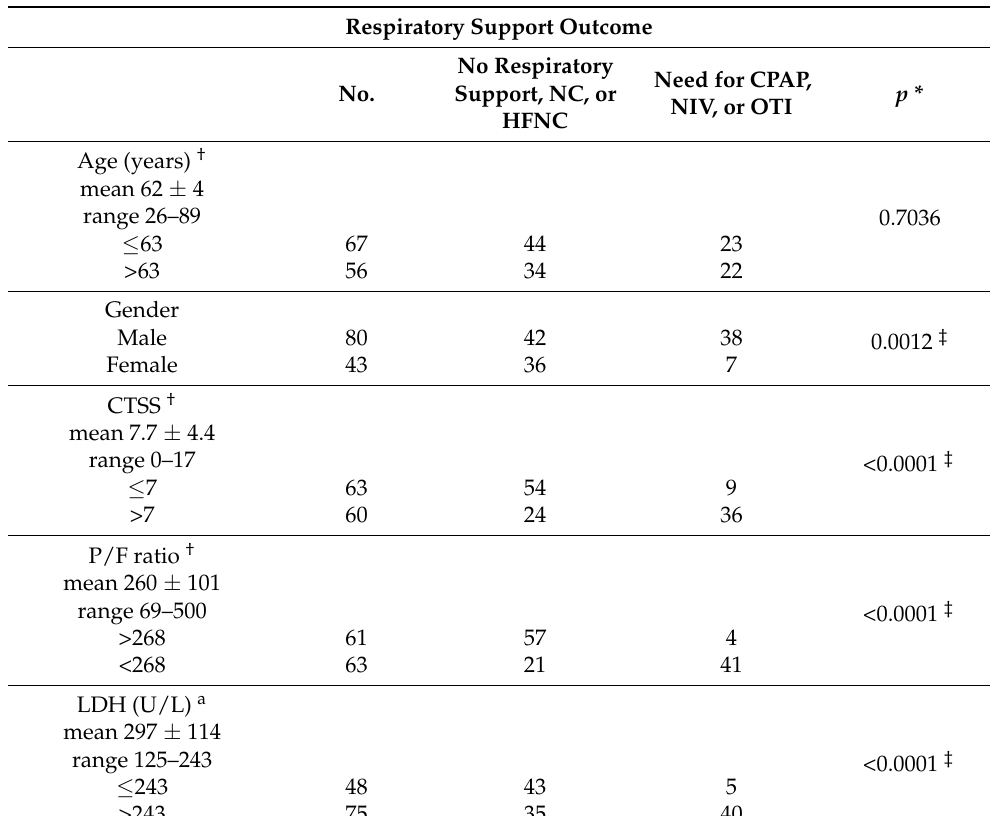
Table 1. Clinicopathological characteristics and respiratory support